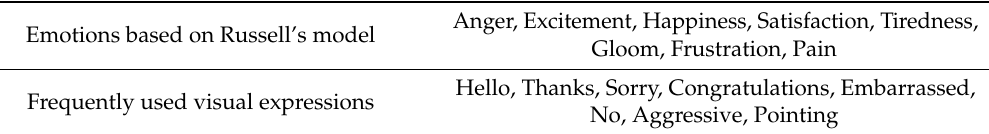
Table 2. Emotions and expressions used in our